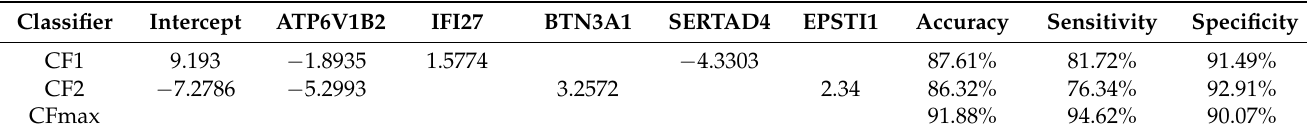
Table 4. Characteristics of the top-performing five-gene classifier using the data from [35] and NP/OP swab PCR-sample data to classify COVID-19 patients and other viral ARIs and non-viral patients into their respective groups.